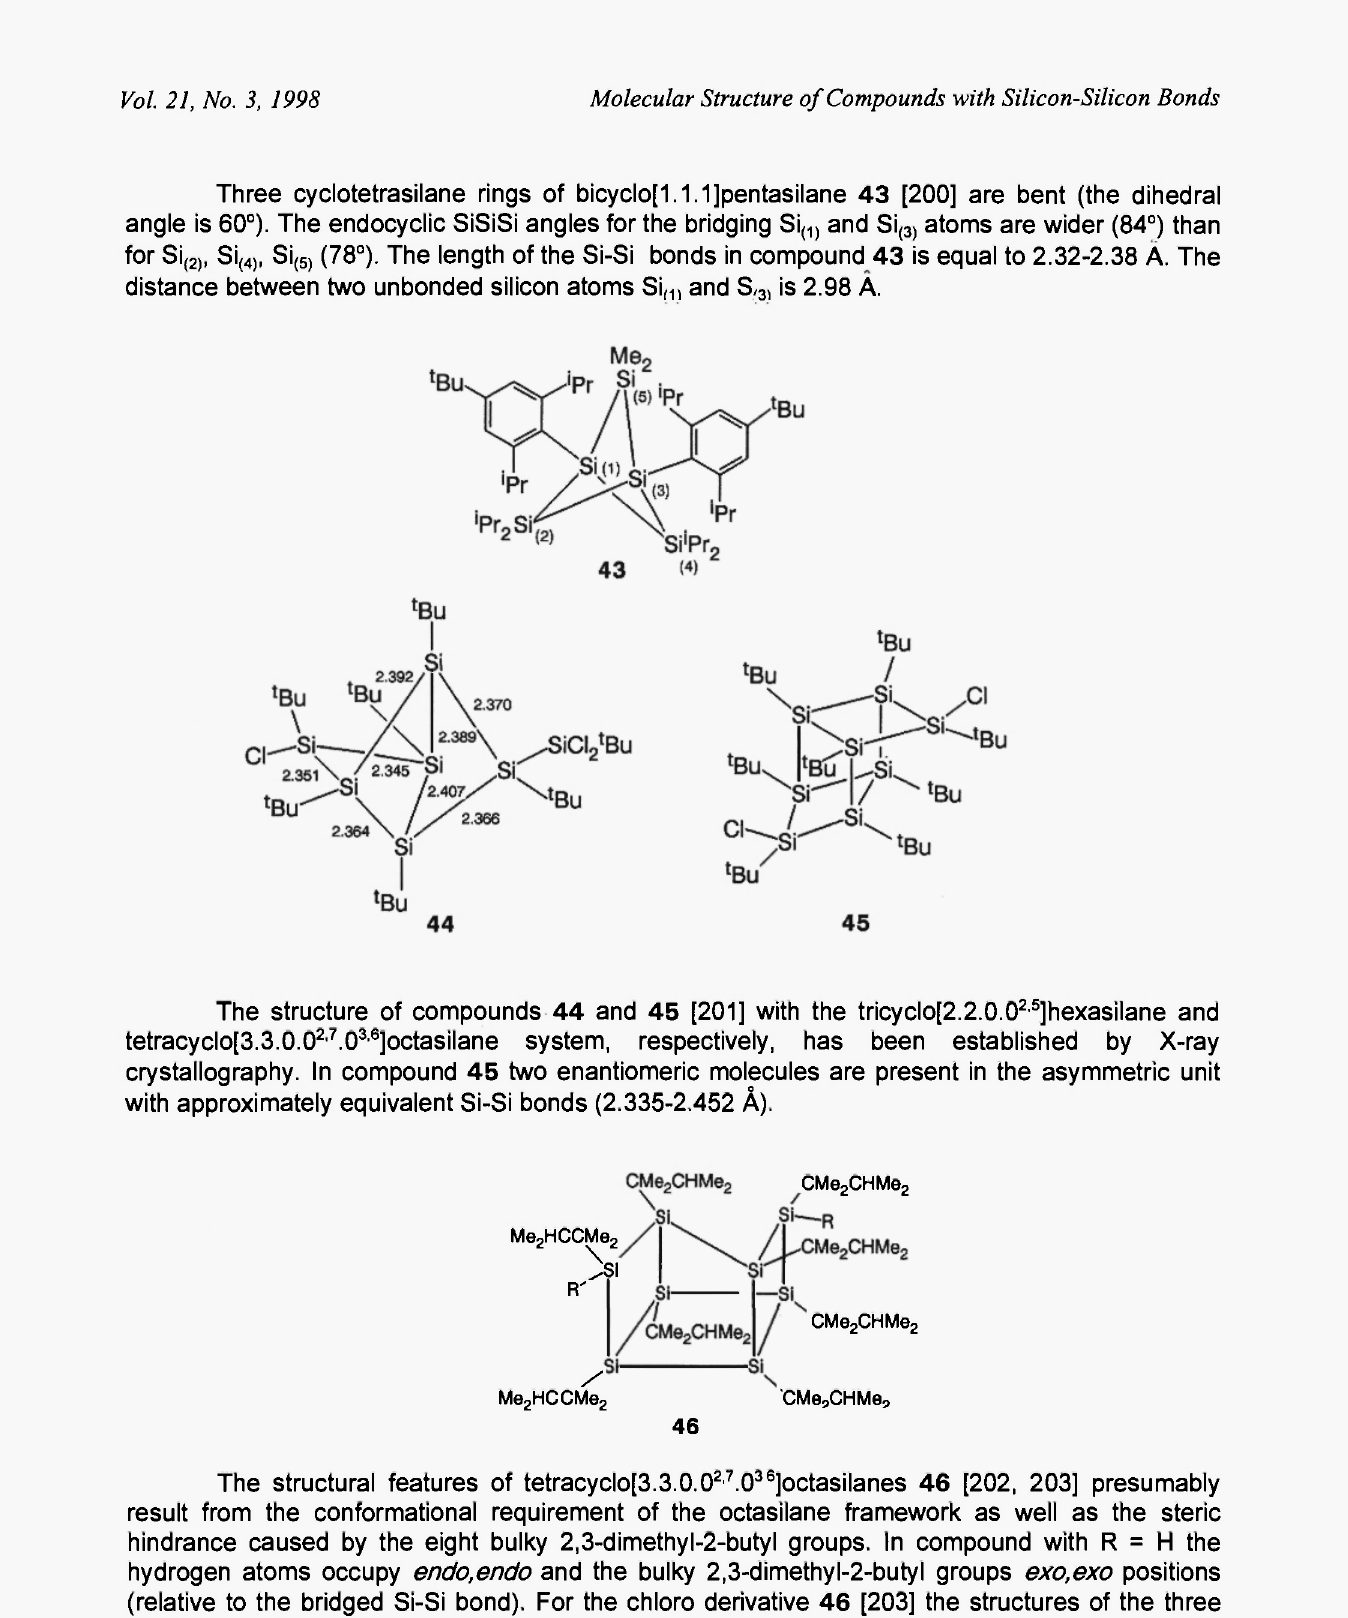
result from the conformational requirement of the octasilane framework as well as the steric hindrance caused by the eight bulky 2,3-dimethyl-2-butyl groups. In compound with R = Η the hydrogen atoms occupy endo,endo and the bulky 2,3-dimethyl-2-butyl groups exo,exo positions (relative to the bridged Si-Si bond). For the chloro derivative 46 [203] the structures of the three possible endo,endo, exo,exo and endo,exo stereoisomers were determined. The